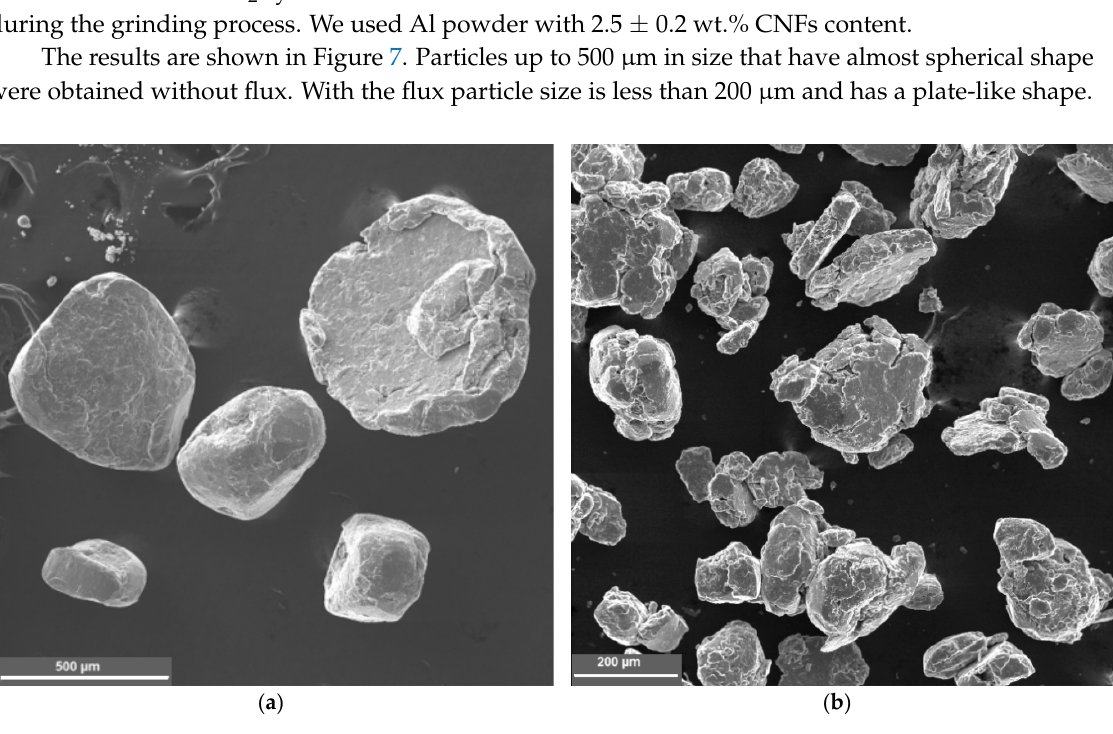
Figure 7. Microstructure of composites after processing in planetary mill ( a ) and carbon distribution in composite particles ( b ).